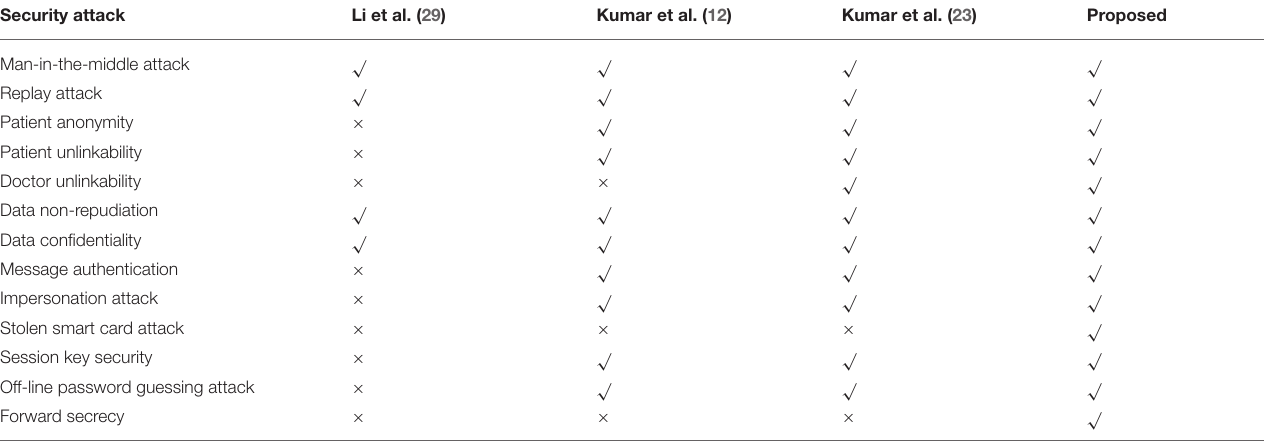
TABLE 1 | Security feature comparison of various protocols.